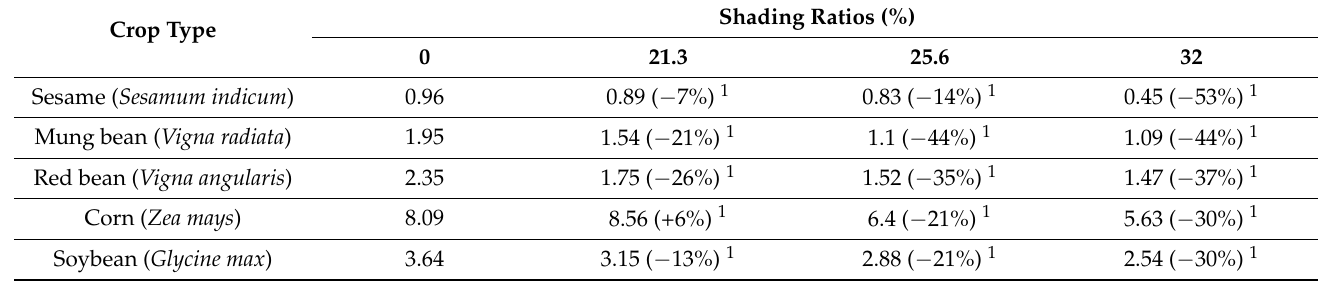
Table 3. Harvested grain yields (Mg/ha) of all five crops grown in four different degrees of shade [4]. Shading Ratios Crop Type